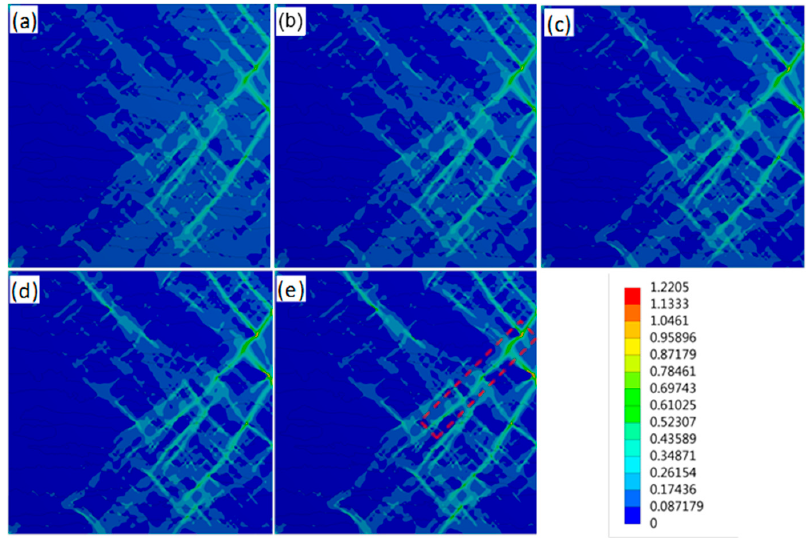
Figure 5. Distribution of equivalent strain within mesostructures as applied load up to tensile strength of different models with σ y , B / σ y , F of ( a ) 2.11, ( b ) 2.37, ( c ) 2.65, ( d ) 2.94, and ( e ) 3.20.